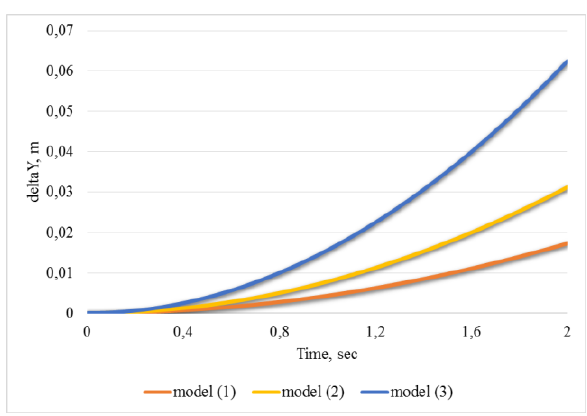
Figure 11. Total errors accumulation along Y axis